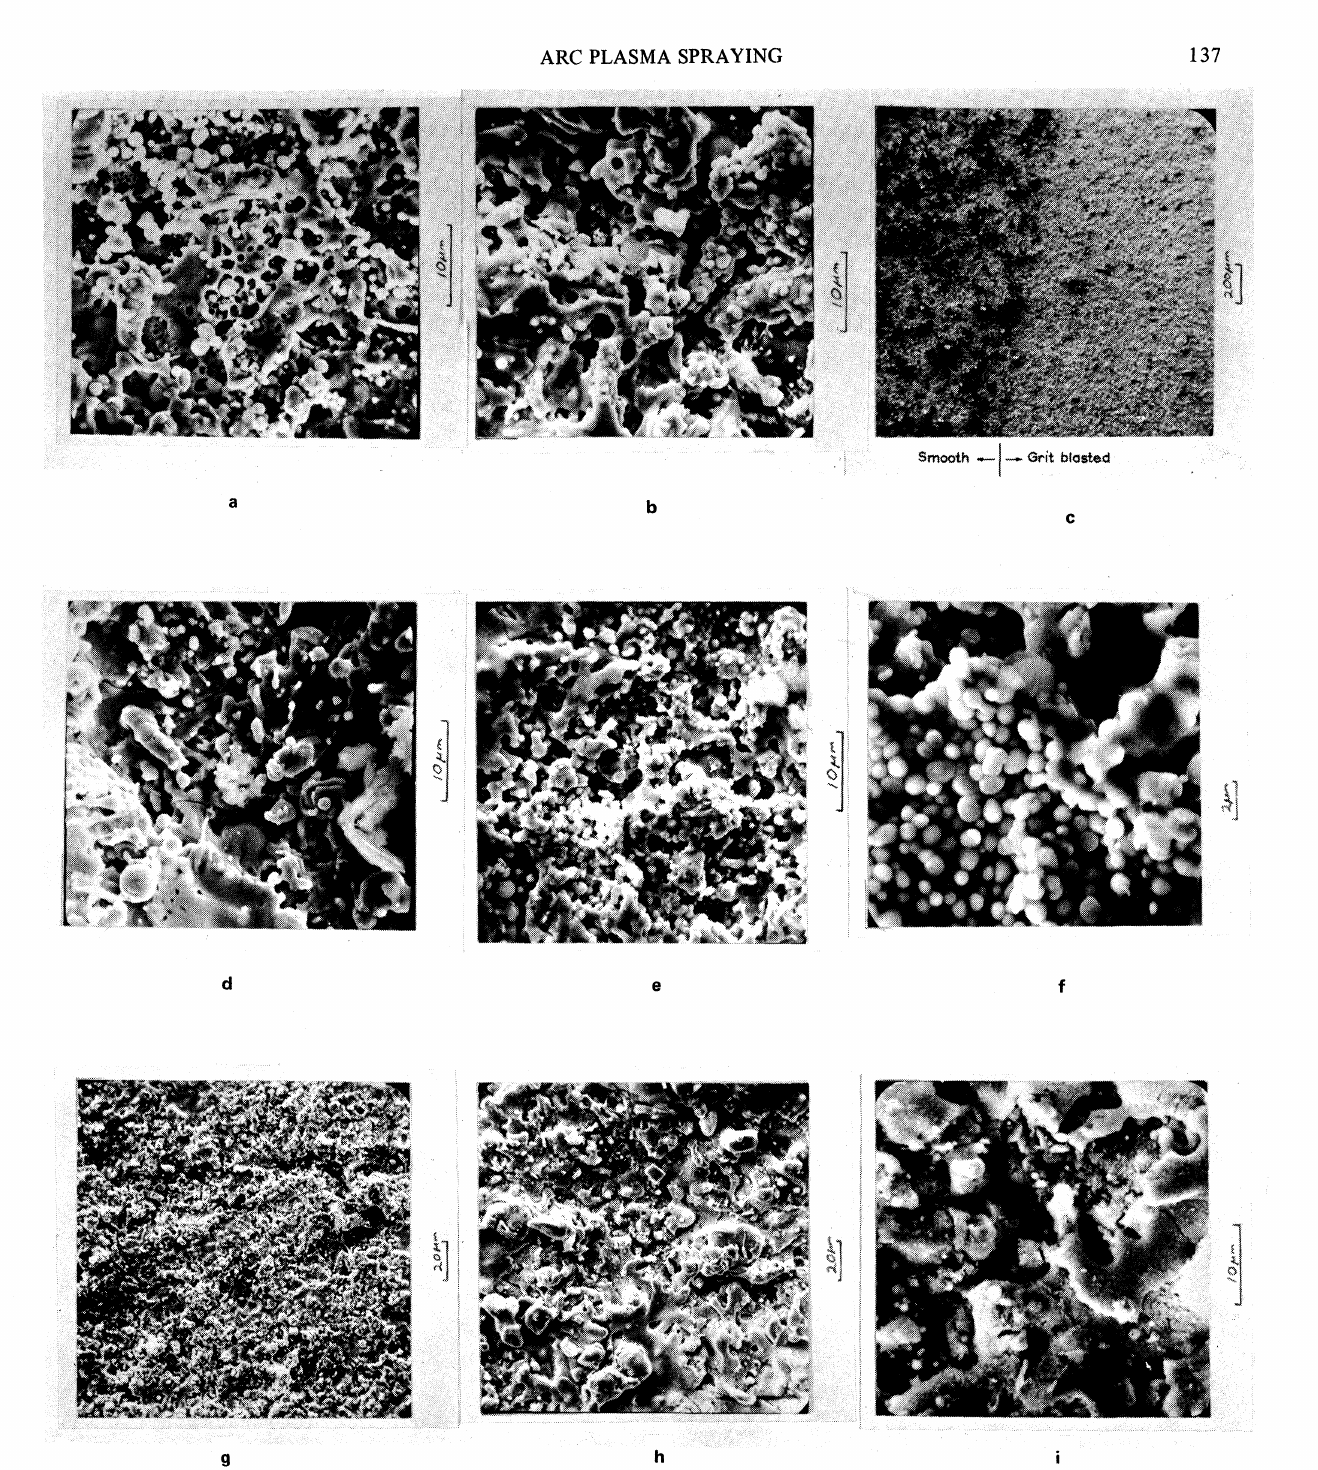
FIGURE 3 All t’ilms are of 1-20 /.tm NiO powder on glass substrates deposited at 200 A, 25 1/min (mach 0.2) except as stated: (a) smooth, (b) grit blasted, (c) division between smooth and grit blasted, (d) mach 0.2, smooth substrate, (e) mach 0.9, smooth substrate, (f) as (e), (g) 1-20/.tm, (h) 20-40/.tm, (i) as